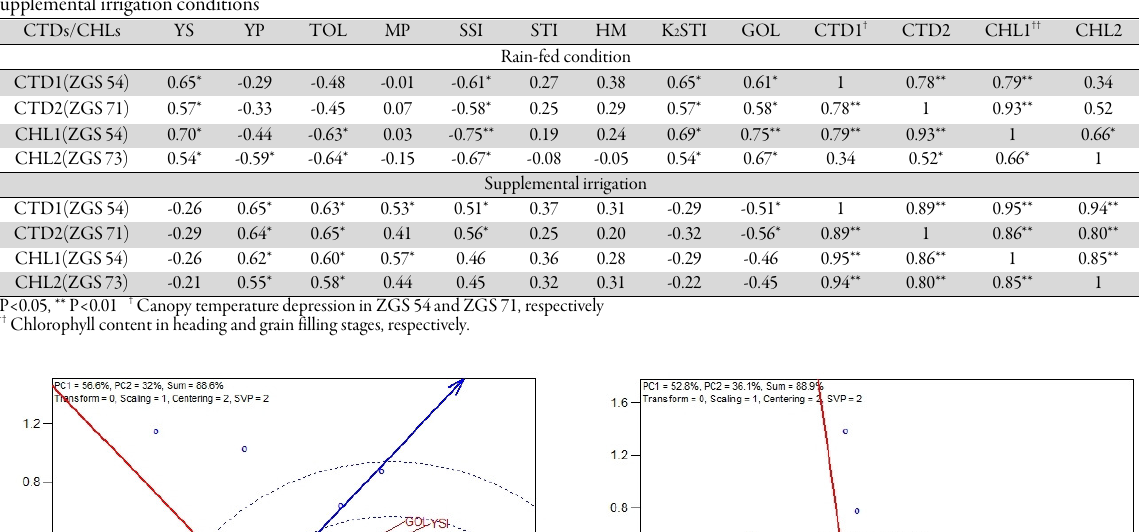
Table 6. Correlation coefficients among CTDs and CHLs values, grain yield and drought indices in durum wheat genotypes in rain-fed and